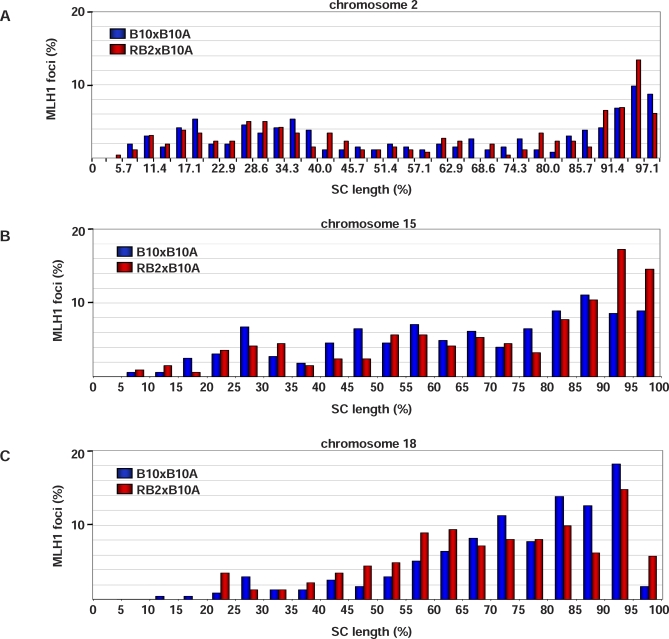
Distributions of MLH1 Foci on Different Chromosomes in B10xB10.A and RB2xB10.A Hybrids(A) Chr 2 divided into 35 intervals of 2.85% SC length (n = 269 and 263, respectively), (B) Chr 15 divided into 20 intervals of 5% SC length (n = 325 and 336, respectively), and (C) Chr 18 divided into 20 intervals of 5% SC length (n = 231 and 265, respectively).